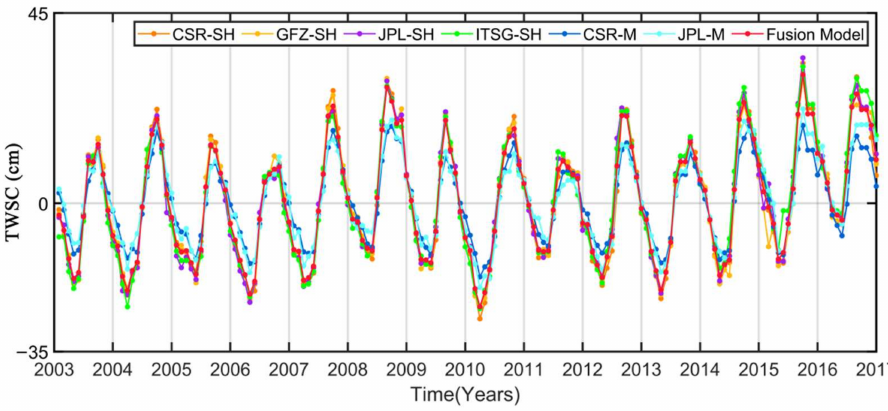
Figure 4. The time-series of TWSC derived from six GRACE solutions and fusion